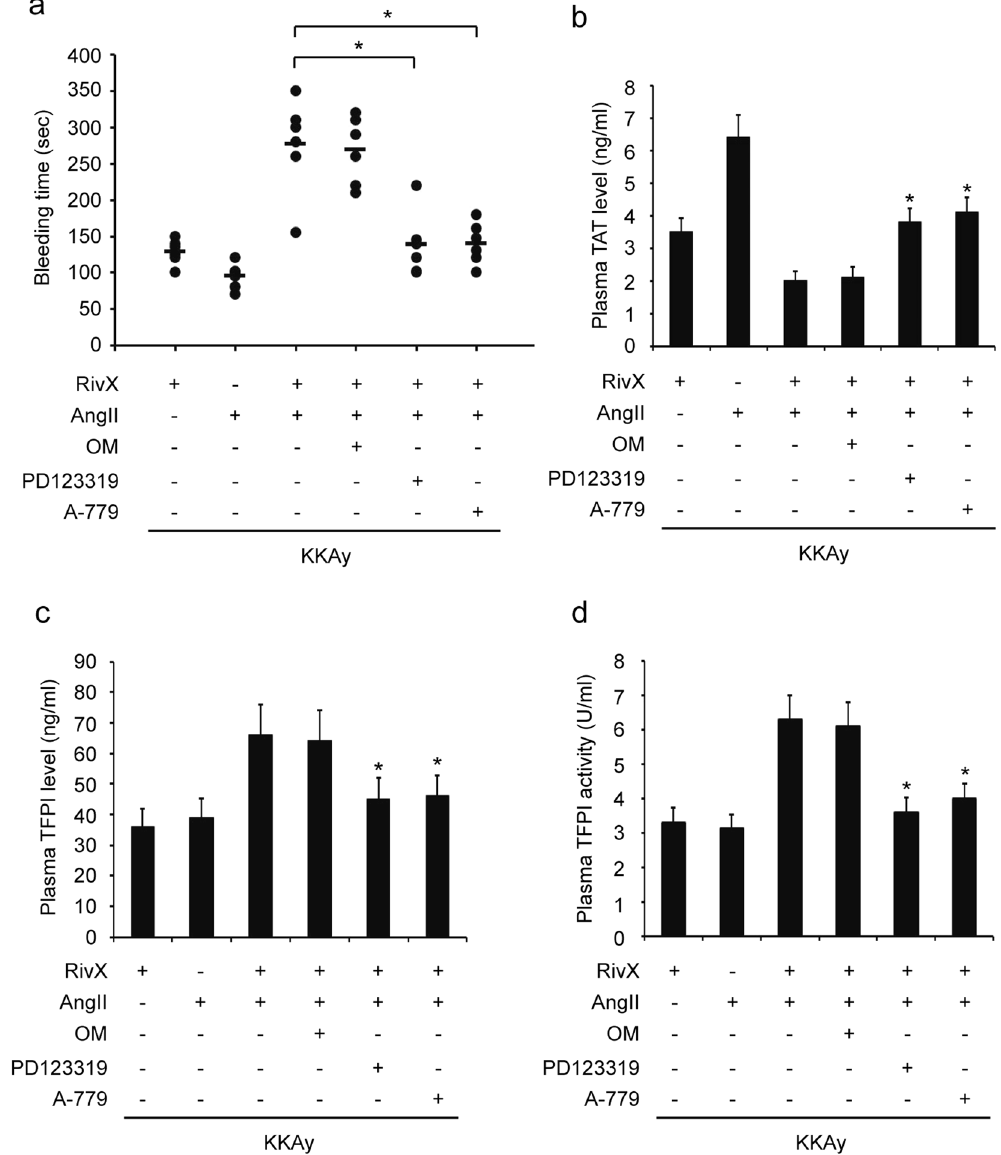
Figure 3. AT2R and Mas antagonist attenuated the AngII-enhanced anticoagulant effects of rivaroxaban. Mice were administered with rivaroxaban (RivX, 5 mg/kg body weight/day) or AngII (1,500 ng/kg/min) in the presence of AT1R antagonist olmesartan medoxomil (OM, 0.5 mg/kg/day), or AT2R antagonist PD123319 (3 mg/kg/day), or Mas antagonist A-779 (2 mg/kg/day) for 2 weeks. ( a ) Under isoflurane anesthesis, bleeding time was assessed. Blood was collected by cardiac puncture to determine the plasma levels of thrombin- antithrombin (TAT) complex ( b ) and TF pathway inhibitor (TFPI) ( c ), as well as the plasma activities of TFPI ( d ). The bars show the mean ± SEM (n = 5–6). * P < 0.05 compared with the parallel RivX and AngII co-treated